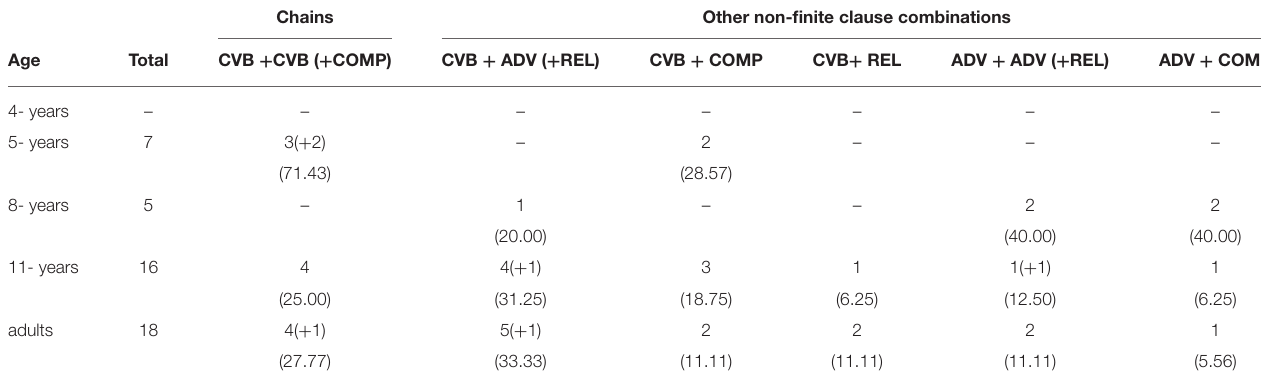
TABLE 7 | Frequency (and percentage) of clause types in 2- and 3-NCL chains and other non-finite clause combinations by age*. Chains Other non-finite clause